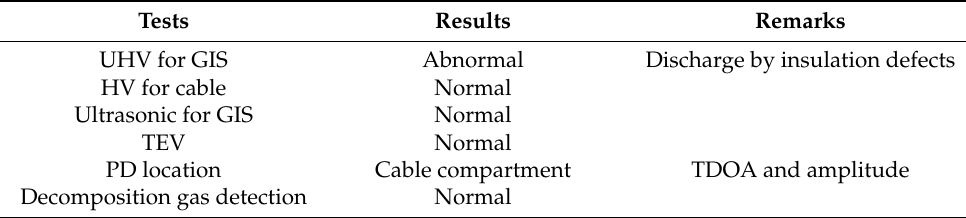
Table 1. Test items and related results of 2215 bay of 220 kV Milan Station.